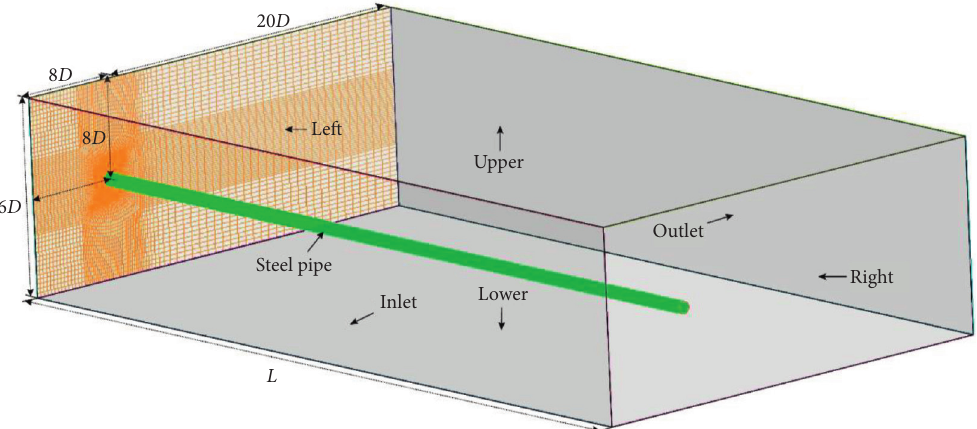
Figure 3: The computational domain and mesh generation.